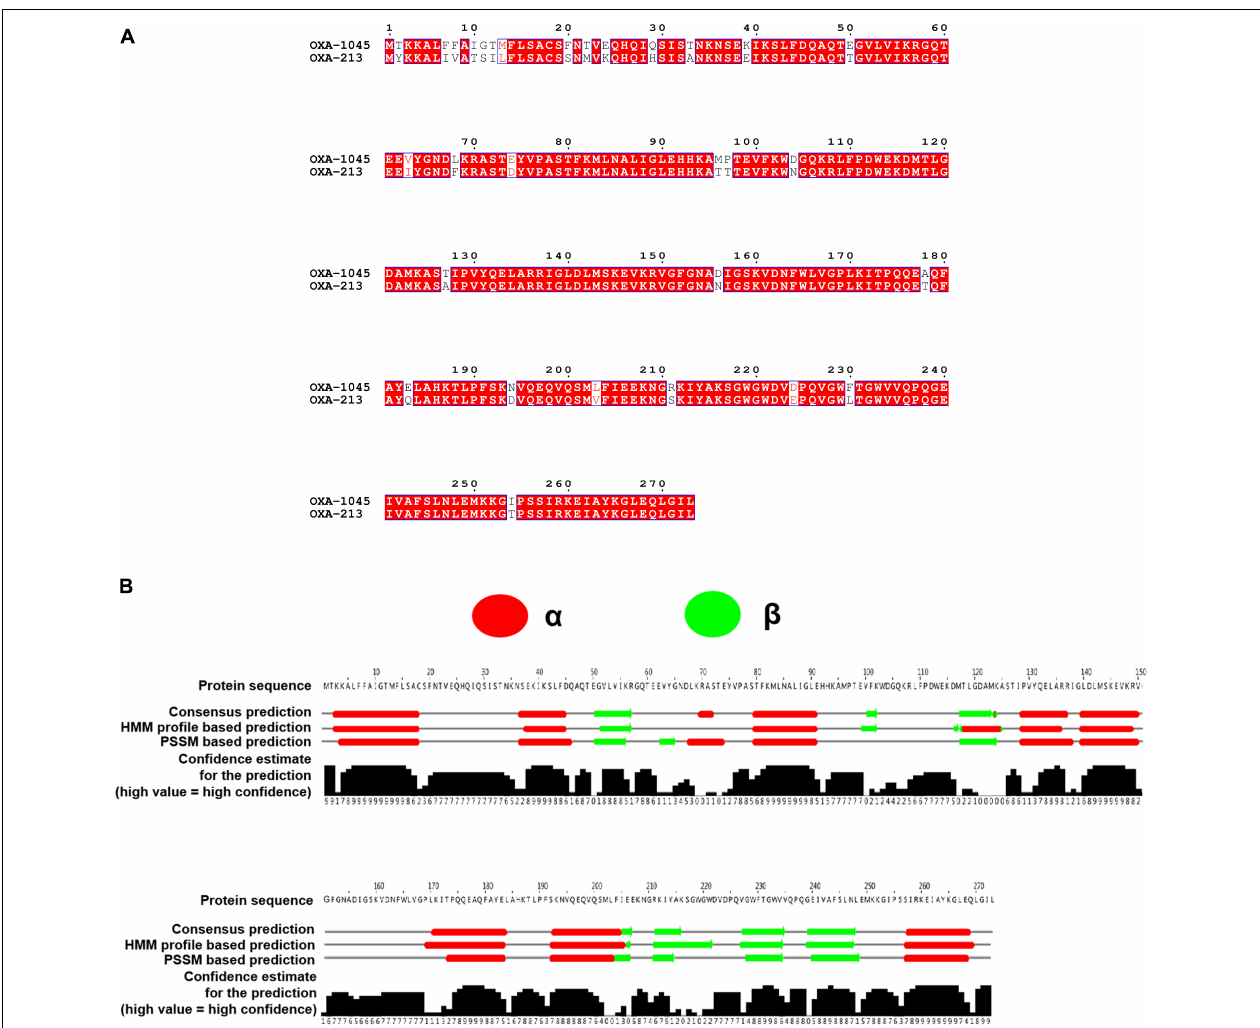
FIGURE 2 | (A) Clustal Omega and ESPript 3.0 were used to align the amino acid sequences of OXA-822 and OXA-213. Residues that have been conserved are highlighted in boxes. (B) Secondary structure of OXA-1045. The secondary structure was predicted using the neural network-based web service JPred4 with the default settings. Secondary structure elements, α helixes, β